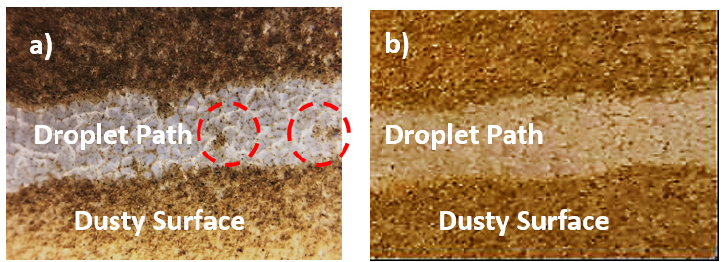
Figure 7. Optical view of droplet path over the dusty sample: ( a ) 2 min treated surface and red dotted regions shows the dust residues in the droplet path; ( b ) 6 min treated surface. Droplet volume is 30 µL and inclination angle ( δ ) of treated surface is 10°.